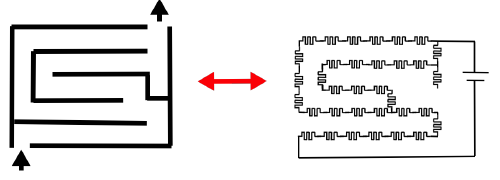
Figure 9. The maze-memristor mapping suggested in